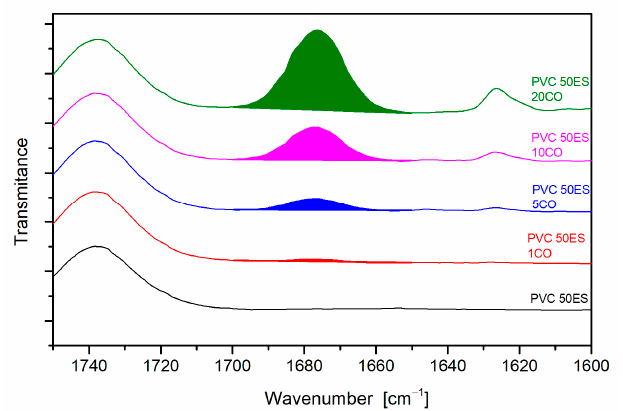
Figure 8. Comparison of the proportions of the active ingredient in materials based on band area analysis at wavenumbers from 1700 cm − 1 to 1650 cm − 1 .